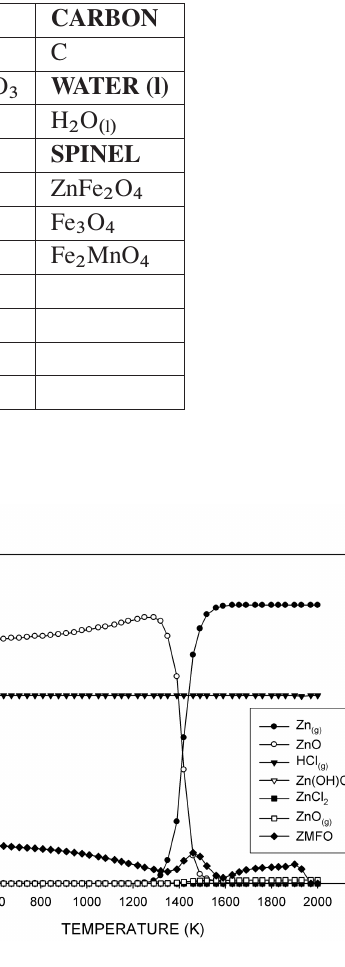
Figure 2. Equilibrium amounts of the zinc-containing species and gaseous HCl as a function of temperature for the Zn-Fe-Mn-O-H-C-Cl system, in the absence of ZnCO 3 , Zn(OH) 2 and Zn 5 (OH) 6 (CO 3 / 2